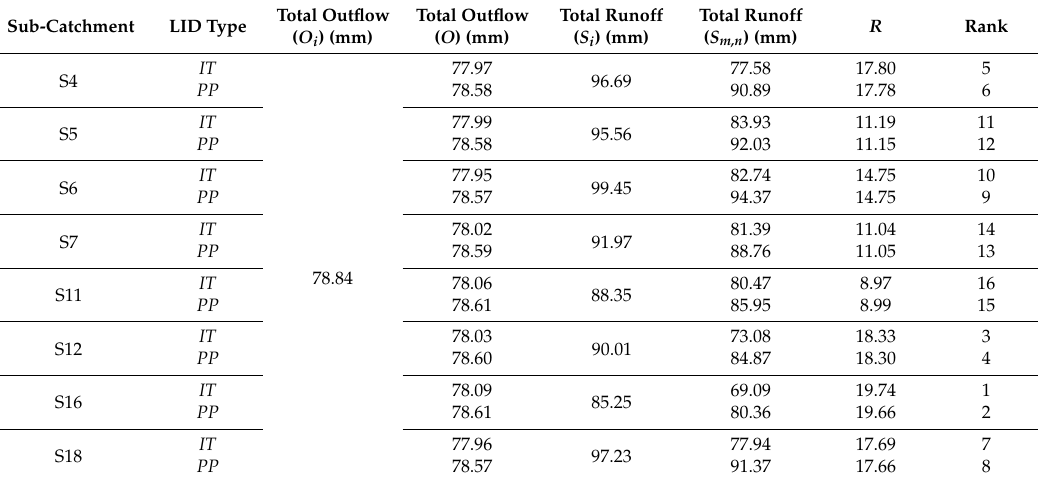
Table 6. Comparison of total runoff by